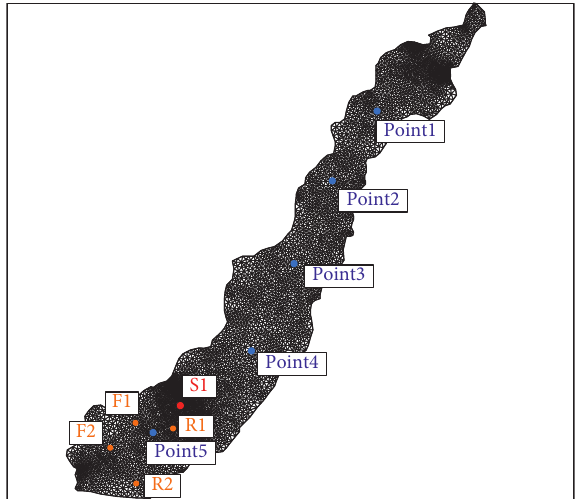
Figure 5: The unstructured triangular mesh in the HTL area.